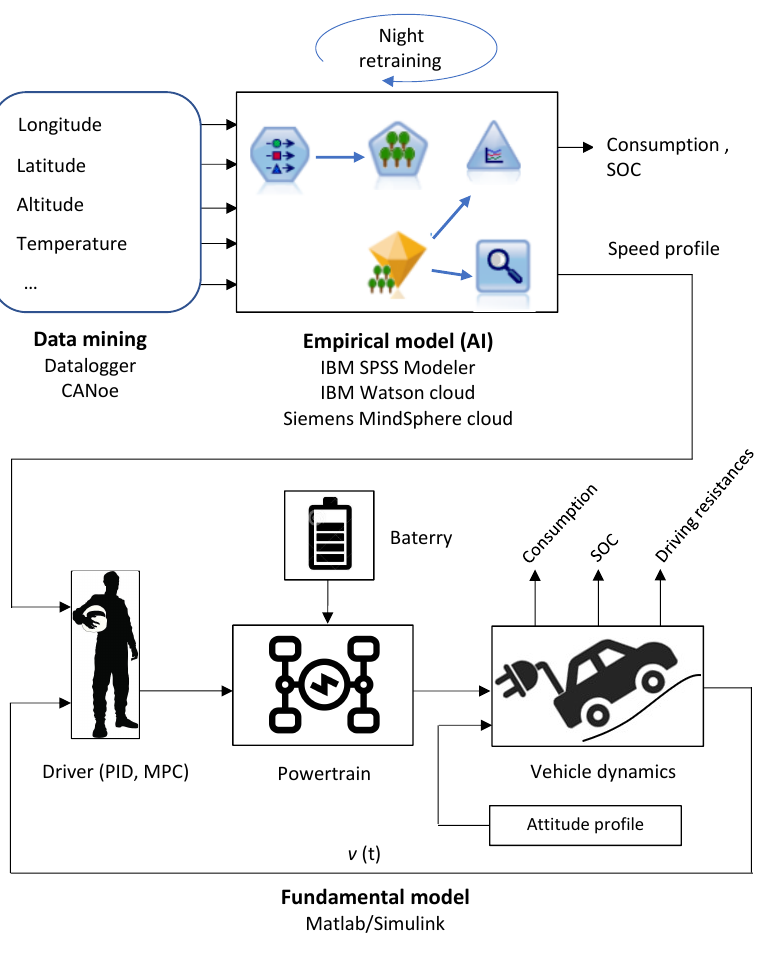
Figure 1. Hybrid model of Biro EV.